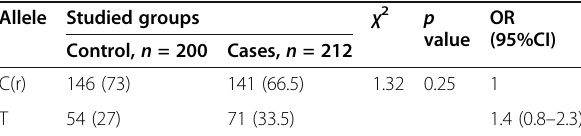
Table 3 MDR1 C3435T allele distribution between cases and